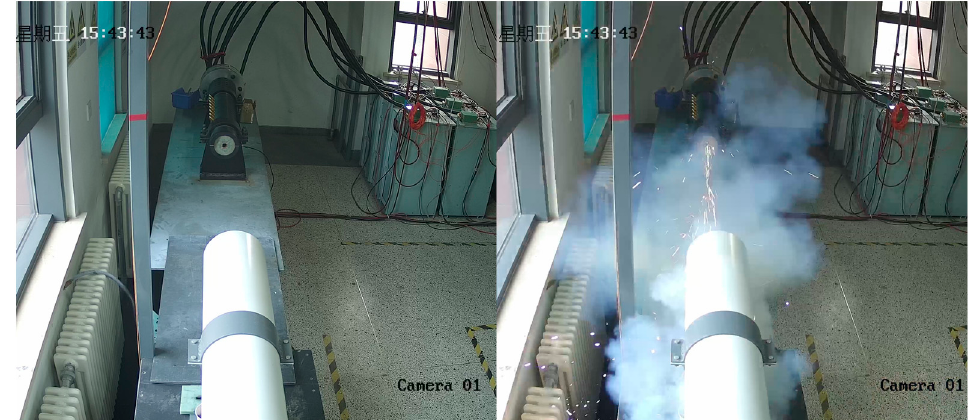
Figure 17. Electromagnetic railgun test platform.